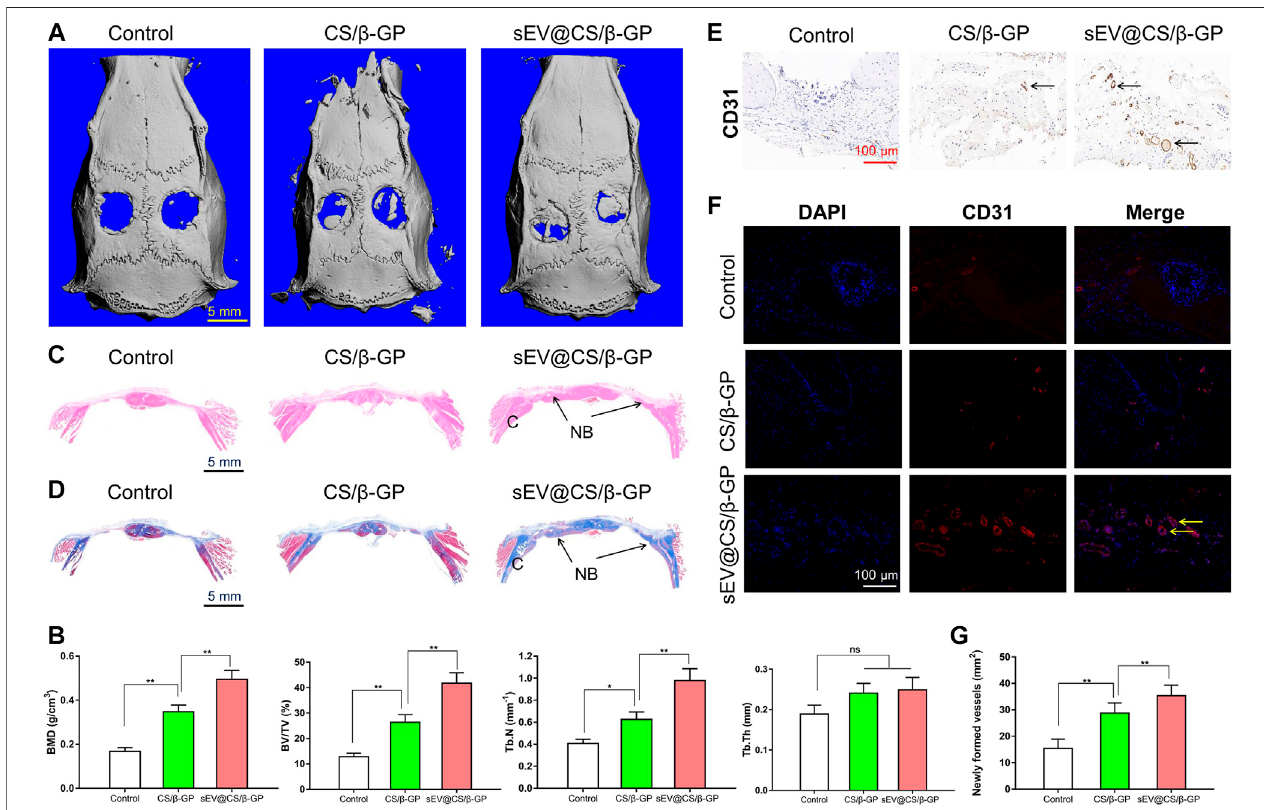
FIGURE 5 | sEV@CS/ β -GP hydrogel promoted bone formation in critical-sized rat calvarial defects (*) p < 0.05 (**) p < 0.01, ns: no signi fi cant difference (A) Micro- CTimagesofbonedefectsineachgroupafter12weeks.Scalebar (cid:1) 5 mm (B) QuantitativeanalysisofBMD,BV/TVratio,Tb.NandTb.Thinthediferentgroups (C) H&E staining and Masson ’ s trichrome staining (D) in the three groups. C, cranium. NB, new bone (E) Immunohistochemical staining and immunofuorescence analysis (F) of the angiogenic marker CD31. Dark brown granules indicating positive staining are marked by black arrows, and yellow arrows mark the newly formed vessels (G) Quantitative analysis of newly formed